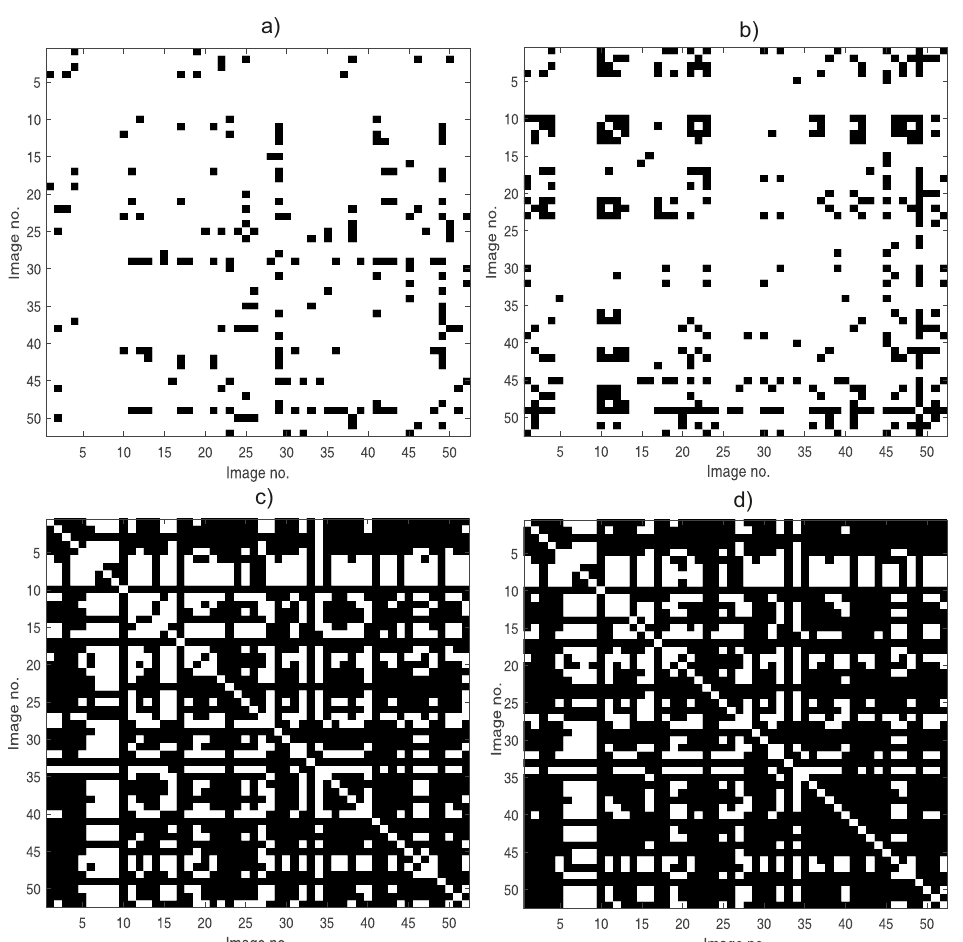
Figure 8. Examples of overlapping: ( a ) box-counting (Case 1), ( b ) box-counting (Case 2), ( c ) lacunarity case (Case 3), ( d ) lacunarity (Case 4). Black is for